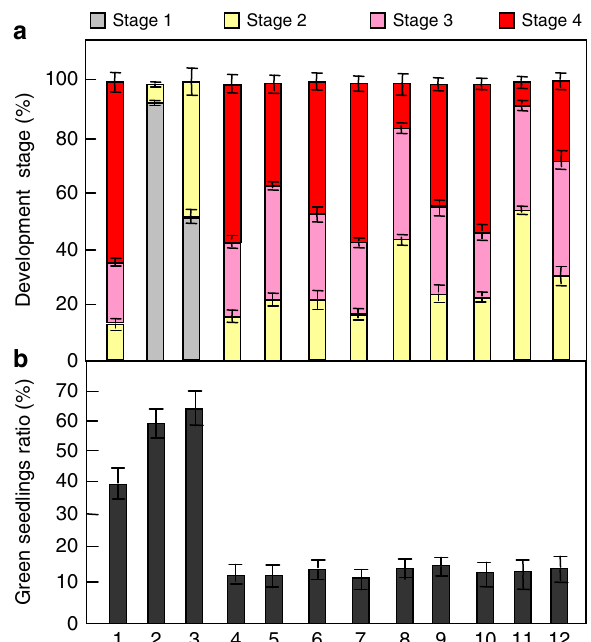
Fig. 3 G-proteins act genetically with BRI1 and BAK1. a Comparison of development stages of Col-0 (1), bri1-301 (2), bak1-4 (3), agb1-2 (4), agb1-2 bri1-301 (5), agb1-2 bak1-4 (6), gpa1-101 (7), gpa1-101 bri1-301 (8), gpa1-101 bak1-4 (9), agg3-3 (10), agg3-3 bri1-301 , (11), and agg3-3 bak1-4 (12). Seedlings were grown vertically on medium supplemented with 1% glucose in the dark for 19 days ( n ≥ 85). b The percentage of the indicated seedlings with green cotyledons. Seedlings were grown on medium supplemented with 6% glucose under constant light condition for 16 days ( n ≥ 72). Values in a.b are given as mean ±